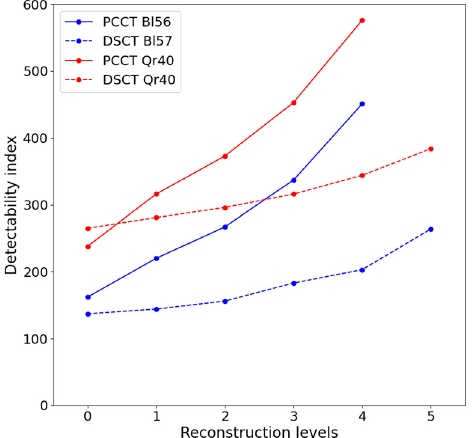
Figure 7. Detectability index on both CTs for polyenergetic (Bl56 and Bl57) and virtual monoener-